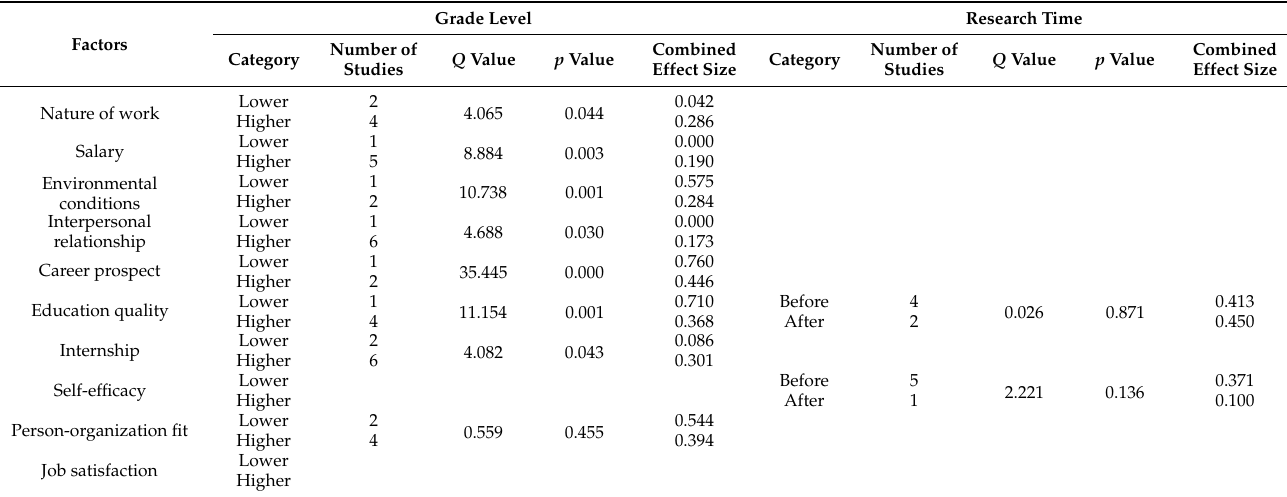
Table 4. Results of random-effects model